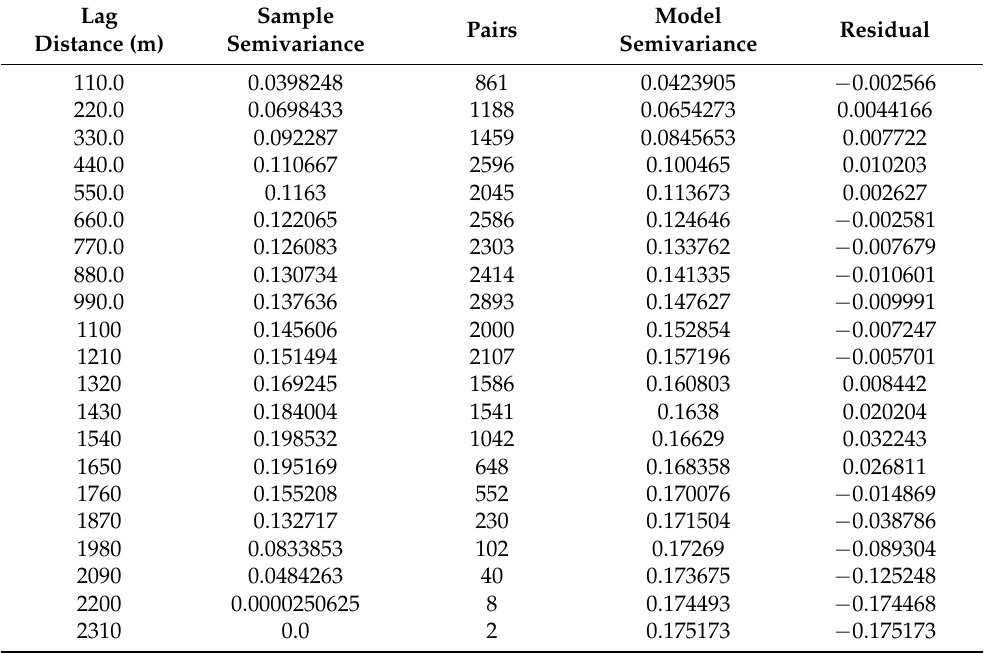
Table 5. Muckaty sample and exponential model semivariance.